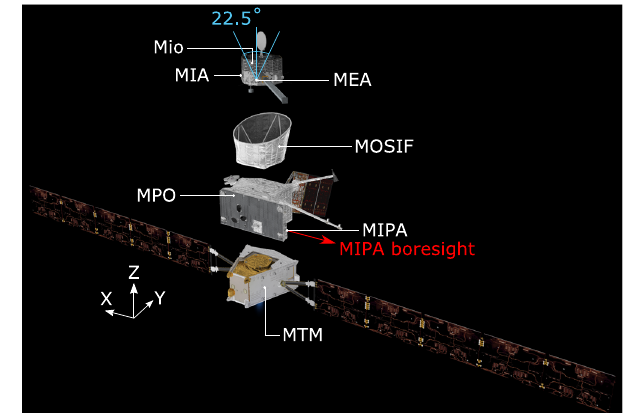
Fig.1|ThetrajectoryofBepiColombo2ndVenus fl ybyinthecylindricalVenus- Fig. 2 | Exploded view of the composition of the BepiColombo spacecraft Solar-Orbital (VSO) coordinates. In VSO the x-axis points along the Venus-Sun during cruise phase. The different spacecraft parts and their names are marked line, the y-axis in the Venus anti-orbital direction and z-axis completes the ortho- p ffiffiffiffiffiffiffiffiffiffiffiffiffiffiffiffi withwhitelines,includingthelocationofMEA,MIAandMIPA.Thetwopixelsofthe : A BepiColombo ’ s trajectory (orange) compared y 2 + z 2 gonal system; here R = MEA instrument FoV which point outside of MOSIF are marked by the blue angles. with the orbit coverage of the missions that have crossed the subsolar magne- The few pixels that point outside of MOSIF for MIA are similar in shape and tosheath,VEx(lightgray)andPVO(darkgray).Theorangearrowheadindicatesthe direction to MEA ’ s, albeitbeing placed on a different location on Mio (MIA ’ s pixels trajectorydirection. B The trajectoryof BepiColombo dividedinto different colors are also shown in Fig. 5) 37 . The boresights of MEA and MIA are along the +Z axis of depending on the plasma region traversed, as identi fi ed from the measurements, the inset coordinate system in white (the MPO spacecraft frame). The boresight where the colorbar de fi nes these regions. Most noteworthy is the maroon color direction of MIPA is marked with the red arrow and is along the − X axis (at a 90° part of the trajectory, which is the barely-explored stagnation region, a subregion angle from MEA and MIA boresights). The total MIPA FoV is along the − X axis and of the subsolarmagnetosheath.The red diamond showsthe closest approach. The covers approximately a wide cone of 80° 49 , where the de fi ned pixels used during backgroundgraycolormappresentstheexpectedoxygen(O)coronadensity 27 .The thisVenus fl yby are shown in Fig. 5. Note thatall acronyms are de fi ned in the main expected location of the sonic line is indicated by the smaller dashed line 7 . In both text. Image by ESA/ATG medialab, adapted by adding names and indicators of panelstheaveragedbowshockandioncompositionboundaryareindicatedbythe instruments under the license CC BY-SA 3.0 IGO. curved and dashed black lines 20 ,